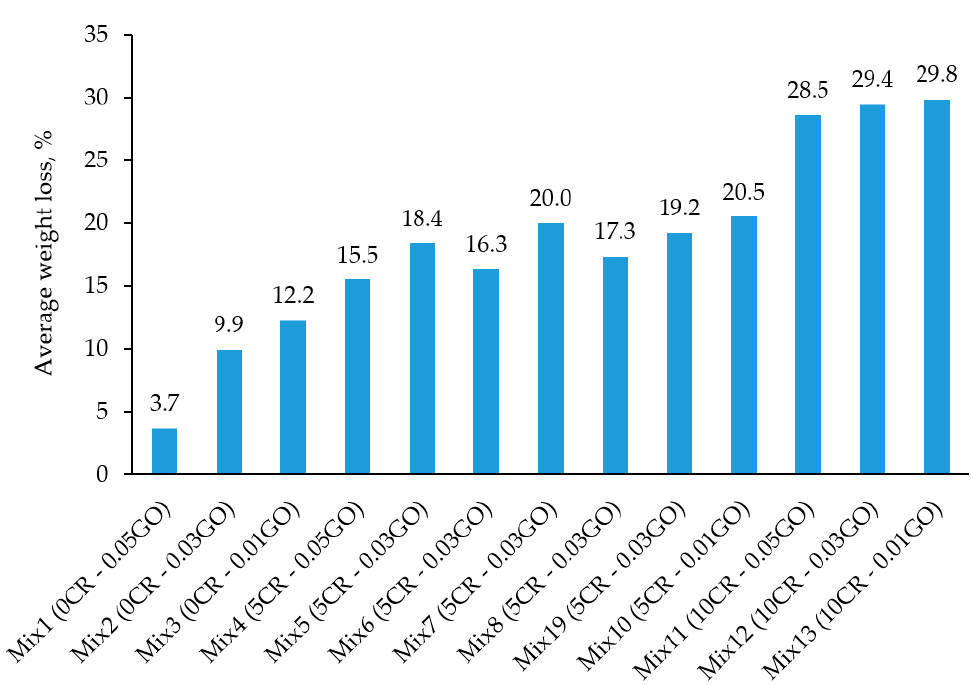
Figure 7. Acid attack test results at 28 days.